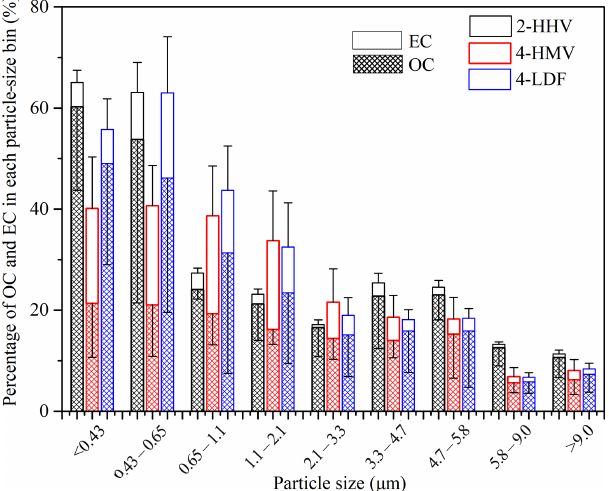
Figure 3. Percentage of OC and EC mass in each particle-size bin (the upper error bar represents the standard deviation of EC, and the lower error bar represents the standard deviation of